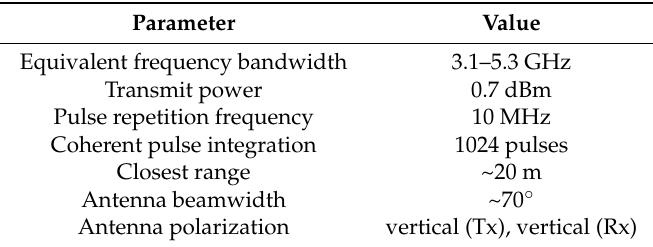
Table 1. Vehicle imaging measurement parameters.